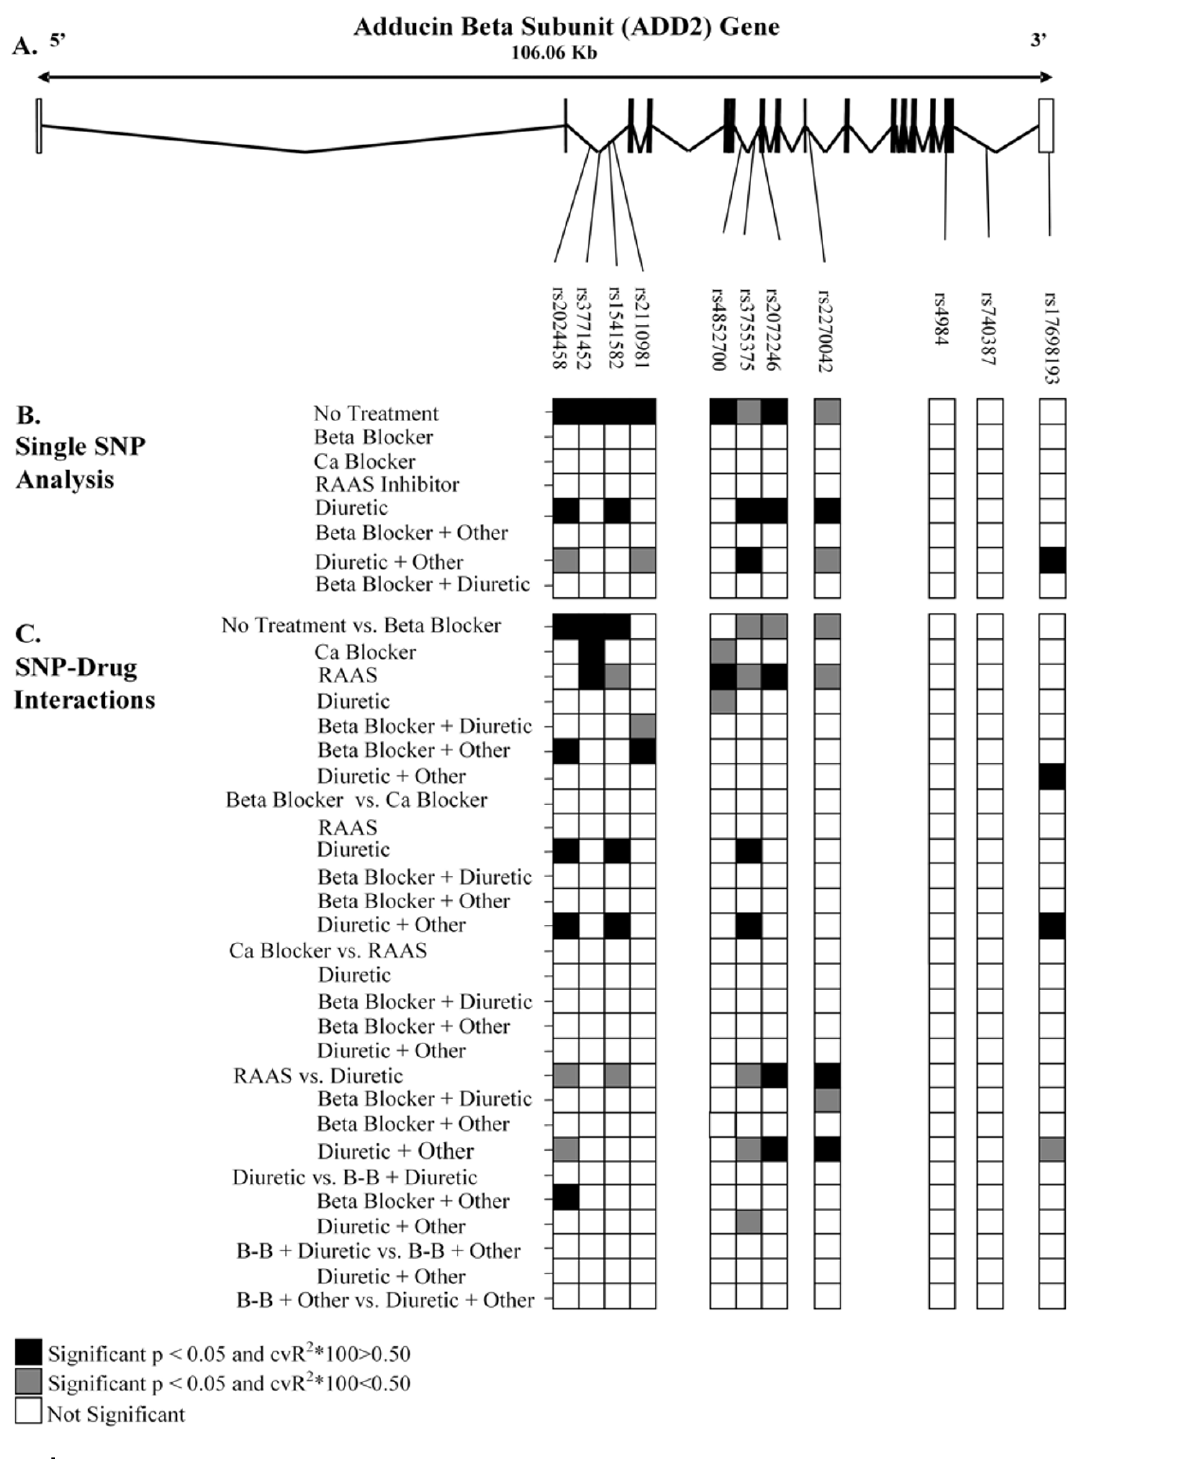
Figure 1 Distribution of ADD2 SNPs on Systolic Blood Pressure within treatment groups and effects of SNP-drug inter- actions A: The location of the 11 SNPs on the ADD2 gene. B: Results from the analysis of each SNP on systolic blood pressure within each drug class. C: Results of the tests for interaction for each pair of drug